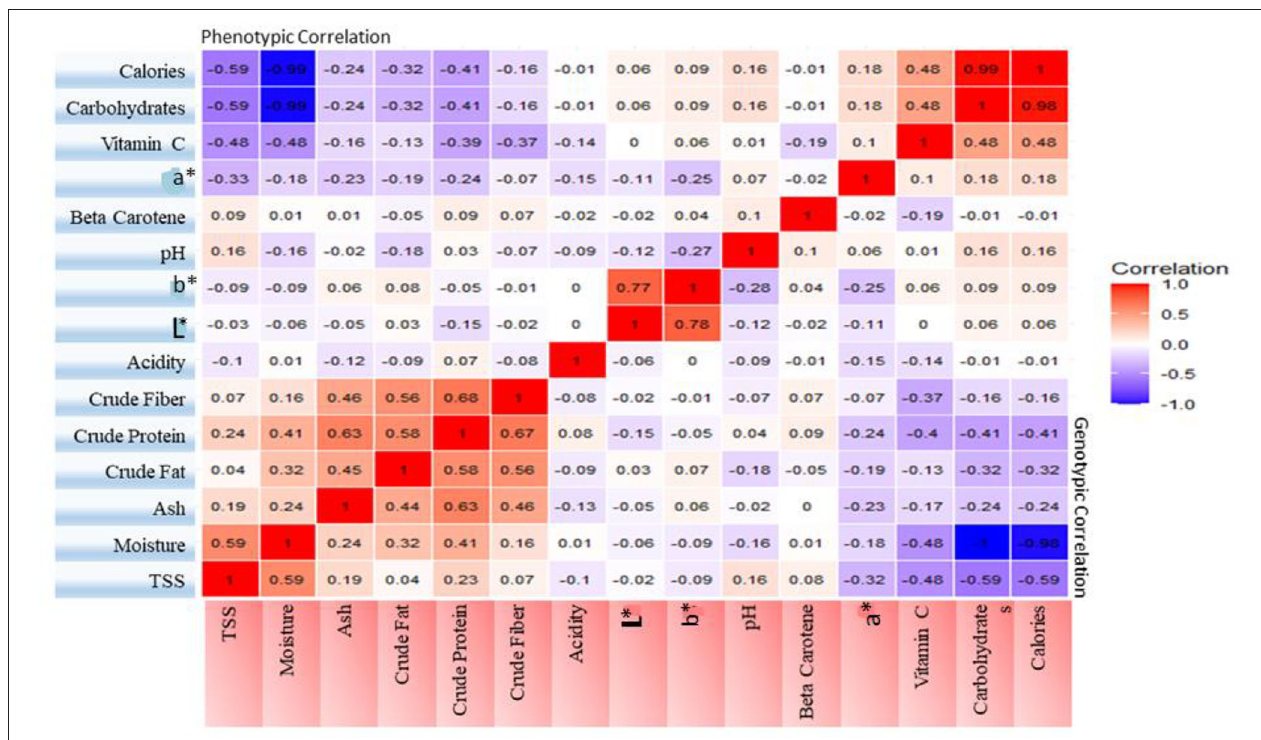
FIGURE 1 | Heat map showing phenotypic and genotypic correlation coefficients among fifteen nutritional